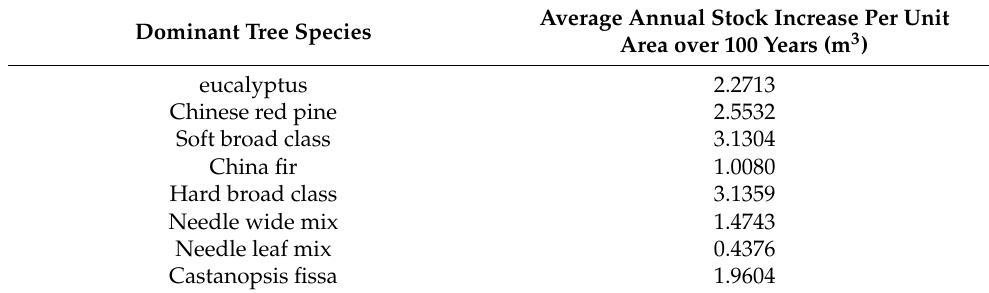
Table 6. Increased stock volume over 100 years per unit area of the dominant tree